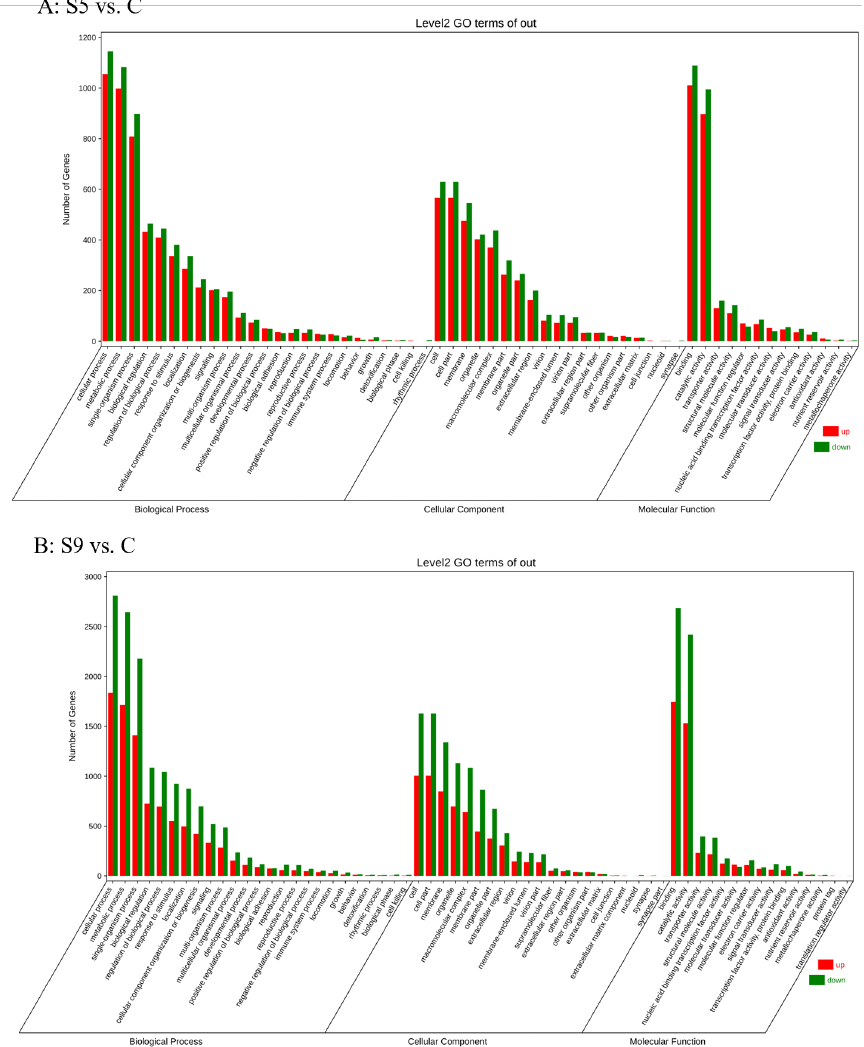
Figure 3. GO enrichment analysis of DEGs in S5 vs. C ( A ) and S9 vs. C ( B ). (C: salinity 30 psu; S5: salinity 50 psu; S9: salinity 90 psu.)